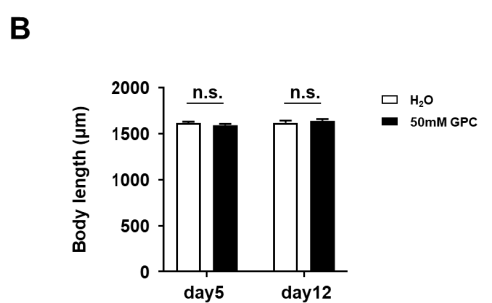
Figure 4. GPC has no adverse effect on the fecundity and body length of C. elegans . ( A ) The number of progenies on days 1, 2, 3 and 4 was scored, and the total number of progenies was summarized. ( B ) The body length of nematodes on days 5 and 12 was measured. n.s., not significant; by two-way analysis of variance (ANOVA) followed by Bonferroni tests. Values are mean ± s.e.m.